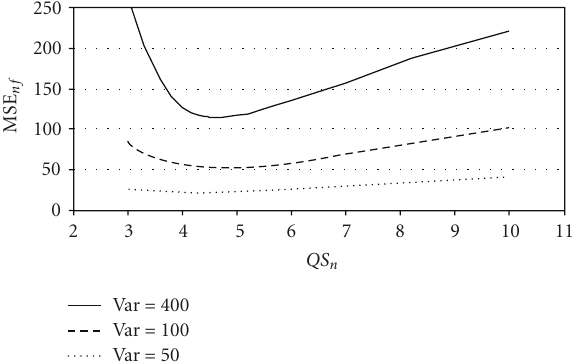
Figure 2: Dependencies MSE nf (QS